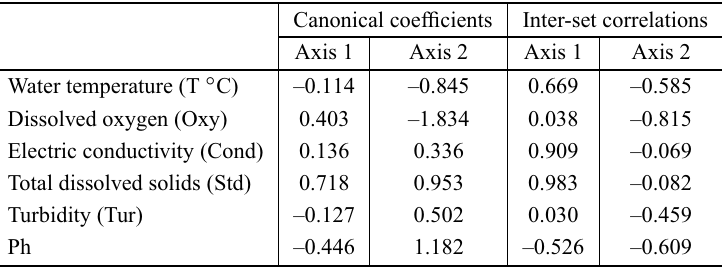
Canonical coefficients and “inter-set” correlation coefficients for the most representative environmental and biological variables on Axes 1 and 2 of the CCA in the Carpina reservoir (PE, Brazil) from January to November